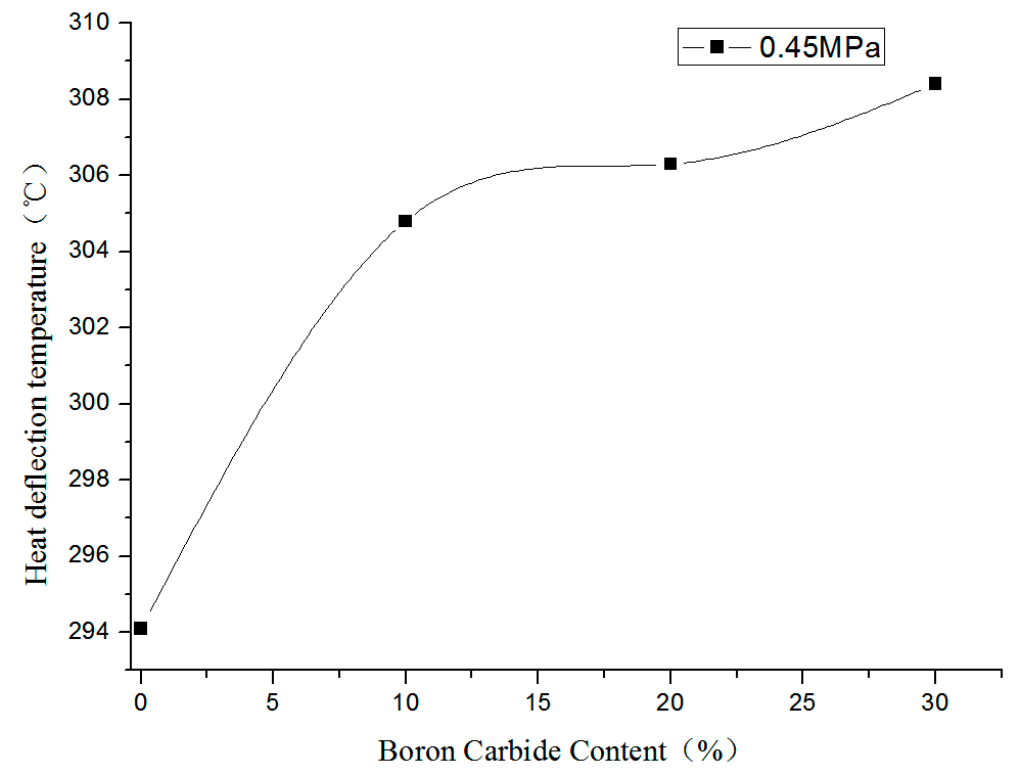
Figure 10. Changes in heat deformation temperature of boron carbide PEEK composites.